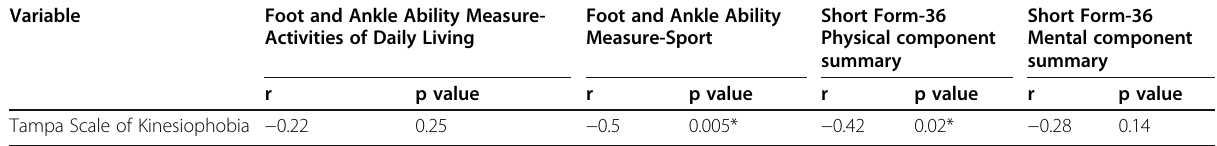
Table 4 Correlations of Tampa Scale of Kinesiophobia with Foot and Ankle Ability Measure-Activities of Daily Living, Foot and Ankle Ability Measure-Sport scores, and Short Form-36 summary scores Variable Foot and Ankle Ability Measure- Foot and Ankle Ability Activities of Daily Living